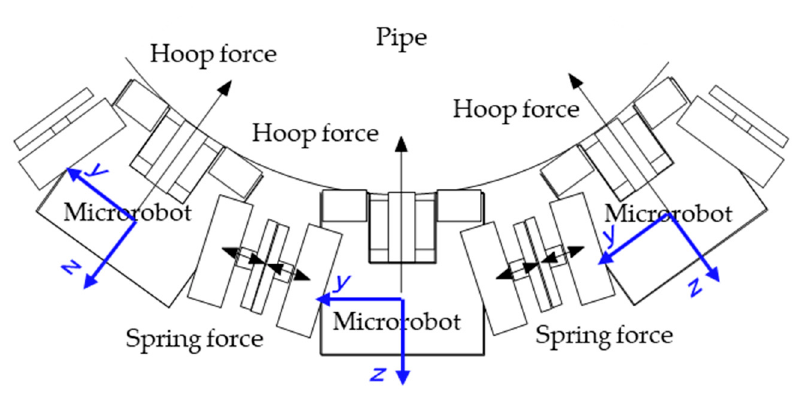
Figure 6. Hoop force acting on the microrobot. The spring force is converted to the microrobot coordinate system and used as an external force in the equation of motion. The hoop force is the force component acting in the negative z direction of the microrobot coordinate system.